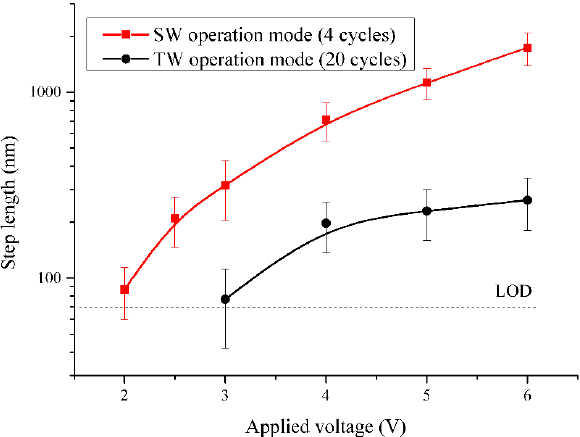
Figure 8. Results from the minimum displacement study of the 2 mg slider at different applied voltages. In the TW operation mode, 20 sinusoidal cycles at 19.55 kHz were used. In the SW oper- ation mode, 4 sinusoidal cycles were used. The limit of detection (LOD) of the optical setup is also